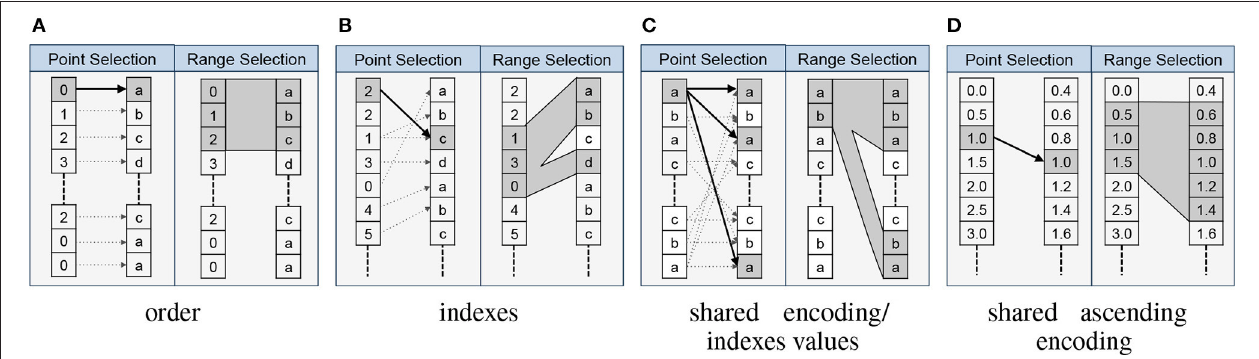
FIGURE 3 | Overview of the main relationship types and the implied mapping of point- and range-based selections from the source to the target object. In each cell we show the source object on the left and the target object of the relationship on the right. (A) For order relationships we can directly map array indices between the data objects. In the case of order relationships involving HDF5 Groups we assume alphabetic ordering of elements. (B) In the case of indexes relationships we map selections by retrieving the relevant indices from the source array. (C) For shared encoding and indexes values relationships we support data selection via value-based data mapping, i.e., we map selections by locating all data values in the target object that match at least one of the values we selected in the source object. (D) Shared ascending encoding relationships behave in general similar to shared encoding relationships, however, the additional constraint that values are sorted in ascending order enables us to map range selections directly based on the minimum and maximum value selected in the source (in contrast to the strict equal value matching of shared encoding ). (E) User relationships define custom user semantics and do not imply a specific mapping between data elements (not